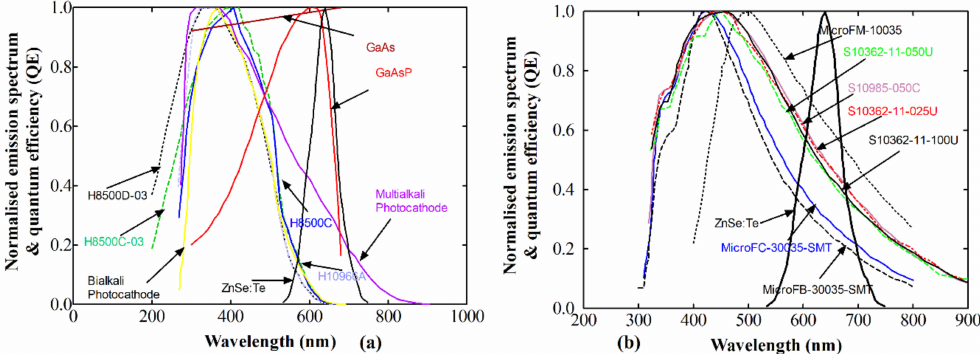
Figure 9. Normalized emission spectrum of ZnSe:Te in comparison with the spectral sensitivities of various sensors: ( a ) photocathodes; ( b ) silicon photomultipliers.